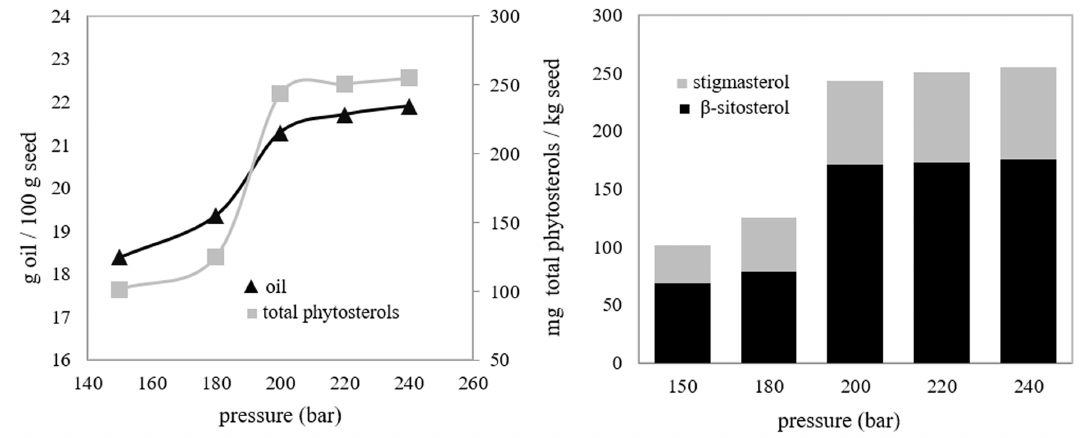
/min, 0.8 mm mean particle size, 2 h. 2